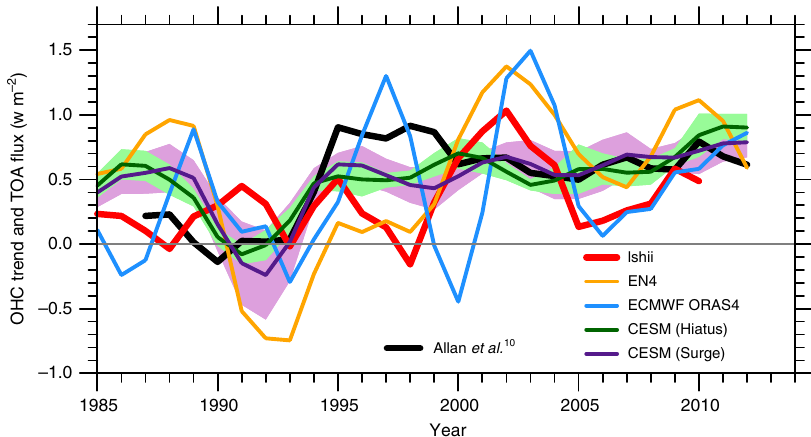
Figure 1 | Energy budget. The five-year running mean global ocean heat content (OHC) trend and net incoming radiation at the TOA from satellites 10,11 (black). The OHC trend is expressed as a flux relative to the total surface area of the Earth and calculated from three observational datasets: the Ishii data 12 (red, 0–1,500m), the EN4 data 13 (orange, full depth) and the European Centre for Medium-Range Weather Forecasts (ECMWF) Ocean Reanalysis System 4 (ORAS4) data 14 (blue, full depth) and the Community Earth System Model (CESM) simulations 15 : the Hiatus/Surge group 1 (dark green/purple curve for the ensemble mean and light green/plum shading for ± 1 s.d. range across ensemble members). Annual mean time series are used in the calculation. The methodology for computing the OHC trend and TOA flux follows Smith et al. 9 The year represents the centre of the time period used to calculate the